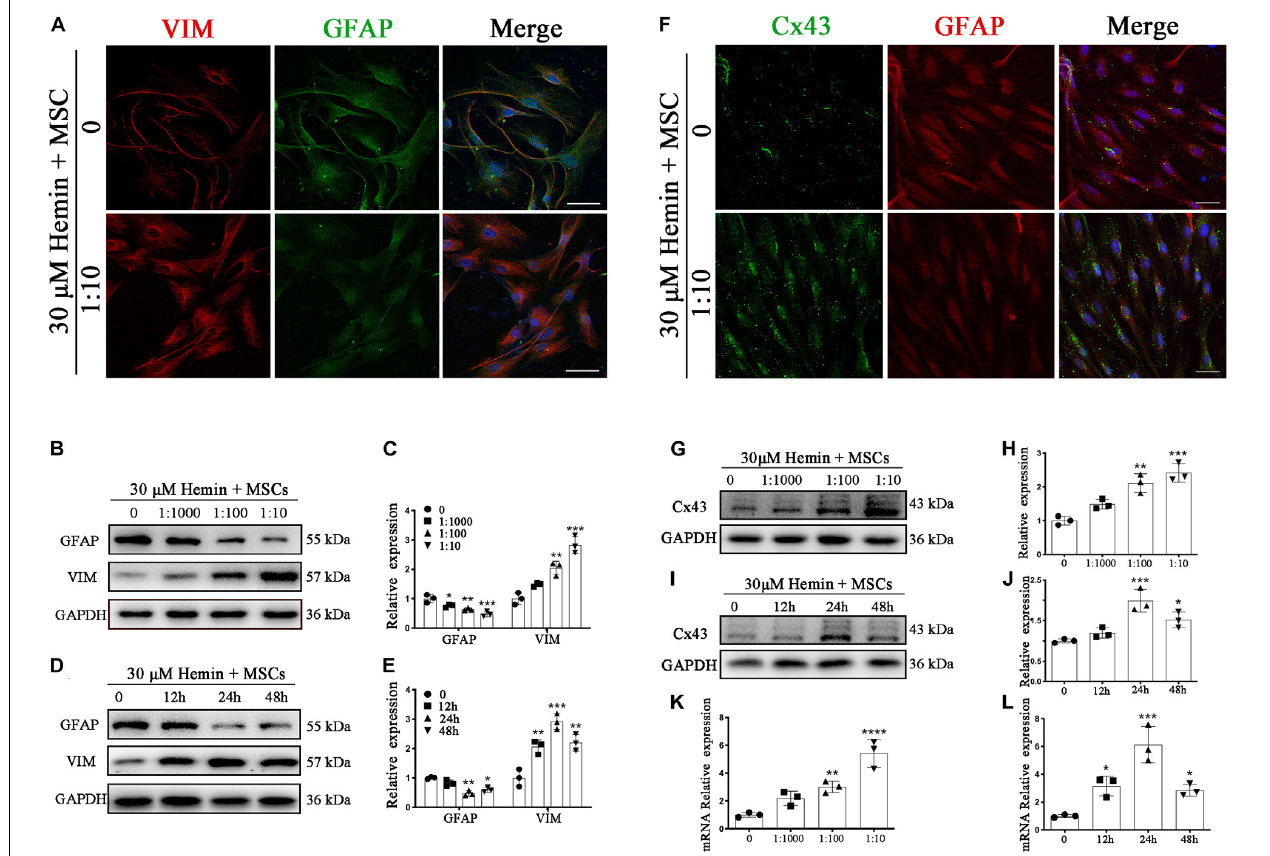
FIGURE 4 | BM-MSCs coculture induced an epithelial-mesenchymal switch, and induced Cx43 upregulation in astrocytes. (A) Immunofluorescence staining of astrocytes for VIM (red) and GFAP (green). The cell nuclei were counterstained with DAPI(blue). Bar = 25 µ m. (B–E) Western blotting analysis of GFAP and VIM in astrocytes exposure to 30 µ M hemin, cocultured with BM-MSCs for indicated times and doses. (F) Immunofluorescence staining for Cx43 (green) and GFAP (red) in astrocytes treated with or without BM-MSCs coculture. The cell nuclei were counterstained with DAPI (blue). Cx43 was expressed on the cell membrane where astrocytes contact, after coculture with BM-MSCs, Cx43 expression was increased. Bar = 25 µ m. (G–J) Western blotting analysis of Cx43 and GFAP in astrocytes exposure to 30 µ M hemin, cocultured with BM-MSCs for indicated times and doses. (K,L) Cx43 mRNA expression of Cx43 in astrocytes exposure to 30 µ M hemin, cocultured with BM-MSCs for indicated times and doses. Expressions were normalized against the internal reference GAPDH. The fold change values were calculated by normalizing to control samples. All data are displayed as means ± SD ( n = 3). The difference between groups was analyzed using One-way ANOVA test. * p < 0.05, ** p < 0.01, *** p < 0.001, compared with control (0 h or 0 µ